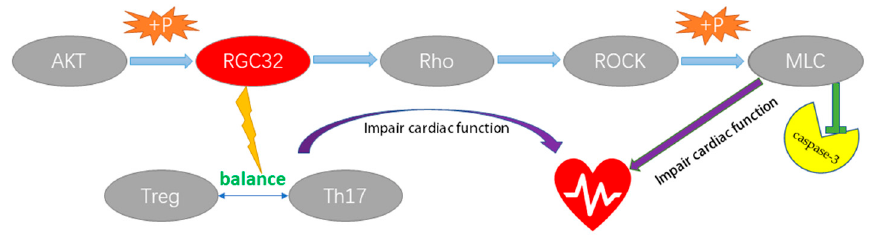
Figure 7. RGC32 may impair cardiac function through the Rho/ROCK axis and immune cell path-